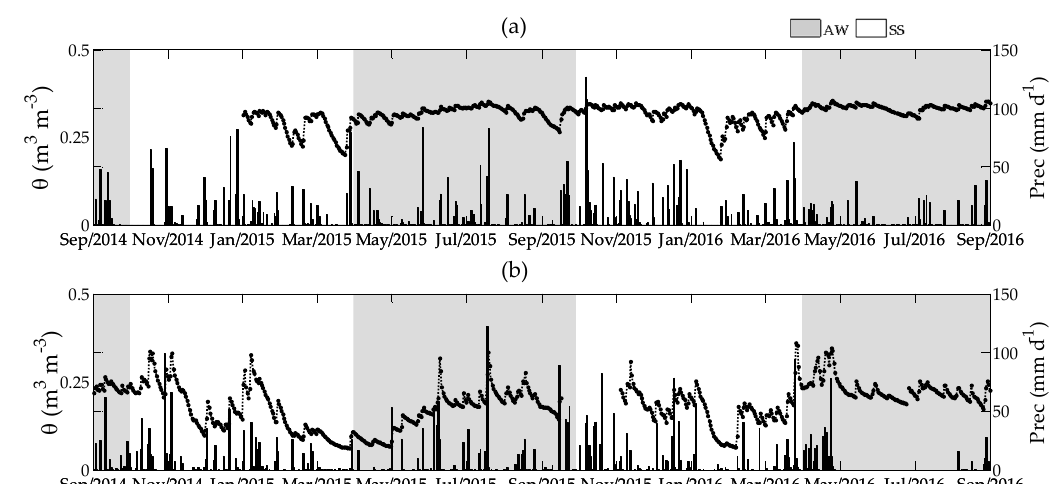
Figure 3. Daily accumulated precipitation, Prec (mm d − 1 ), and volumetric soil moisture at 0.1-m depth, θ (m 3 m − 3 ), for ( a ) SMA and ( b ) PAS. The bar plot represents accumulated daily precipitation and the lines represents θ . The hatched areas indicate the AW periods. Observations were not performed from September 2014 to January 2015 at SMA.